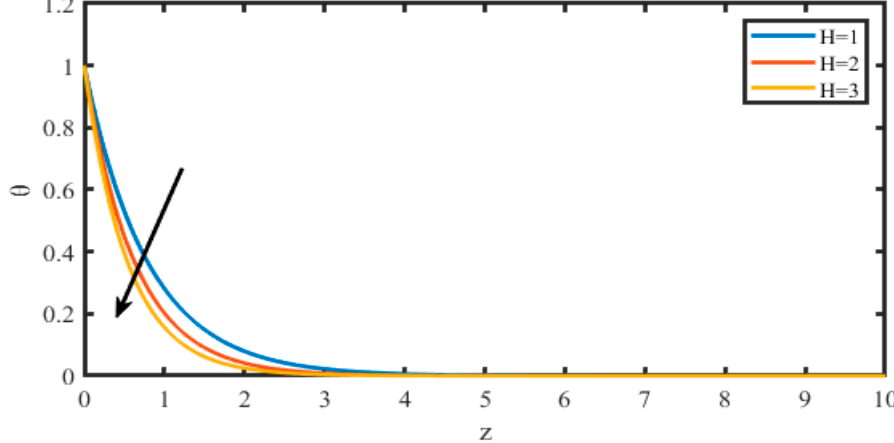
Figure 11. The influence of the Prandtl number parameter Pr on the temperature profiles.